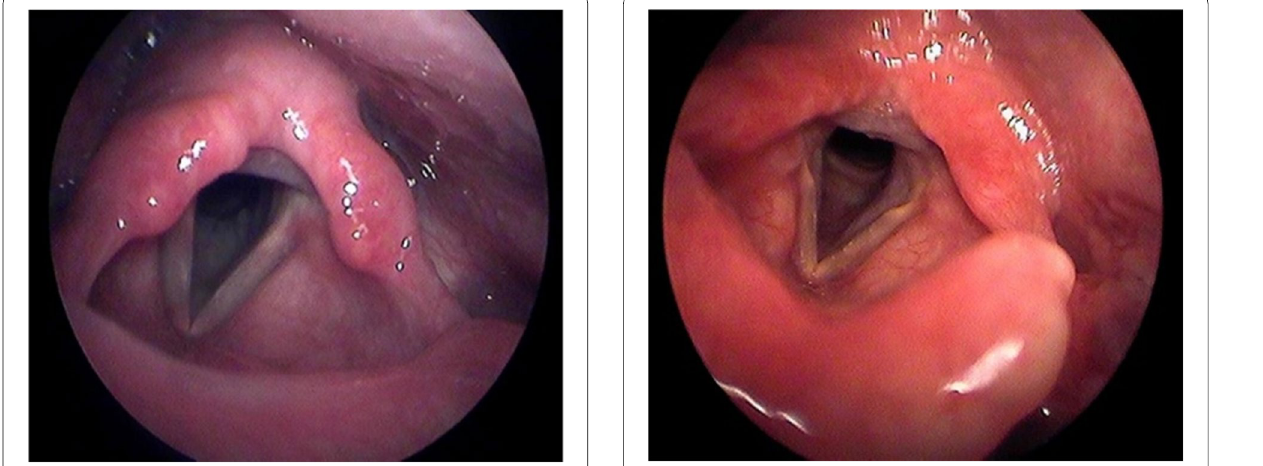
Fig. 2 Mild to moderate LPR showing erythematous arytenoids and posterior commissure hypertrophy